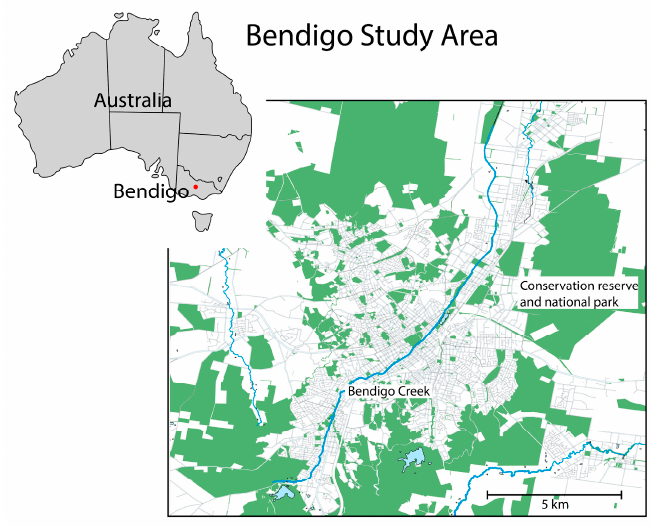
Figure 2. Map of Bendigo.